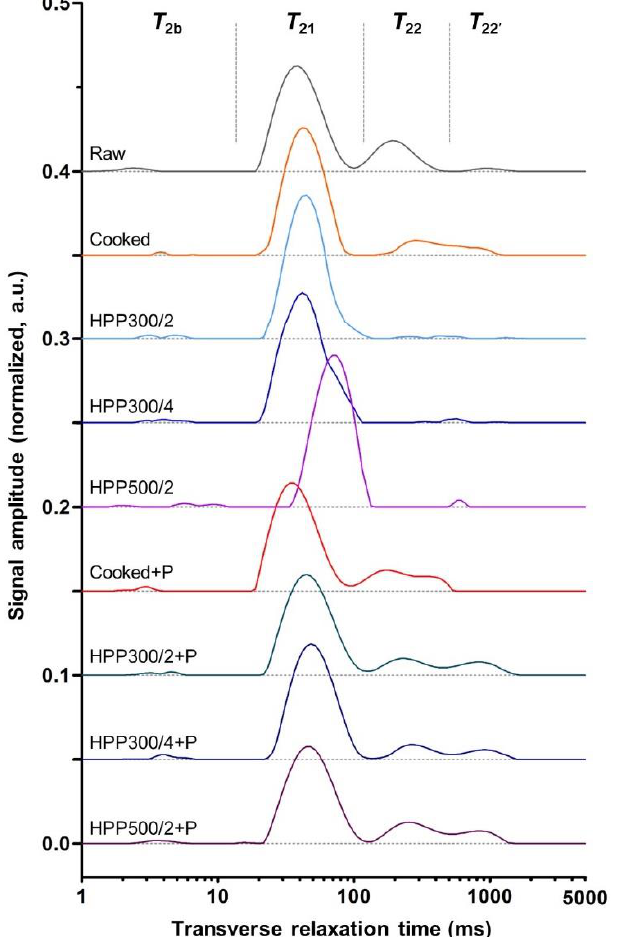
Figure 3. Continuous distribution curves of transverse relaxation time ( T 2 ) obtained by LF-NMR analysis of meat extracted from raw (i.e., untreated), cooked, and high-pressure processed claws, before and after thermal pasteurization (indicated with +P). The signal amplitude is expressed in arbitrary unit (a.u.) and normalized over unitary area. Water relaxation components are indicated with T 2b , T 21 , T 22 , and T 22′ .